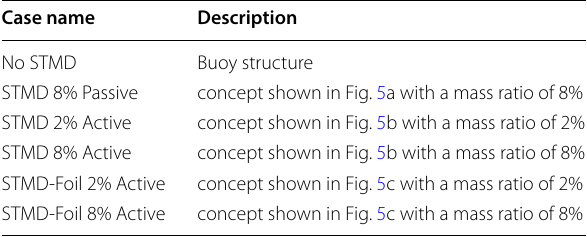
Table 4 Final simulated